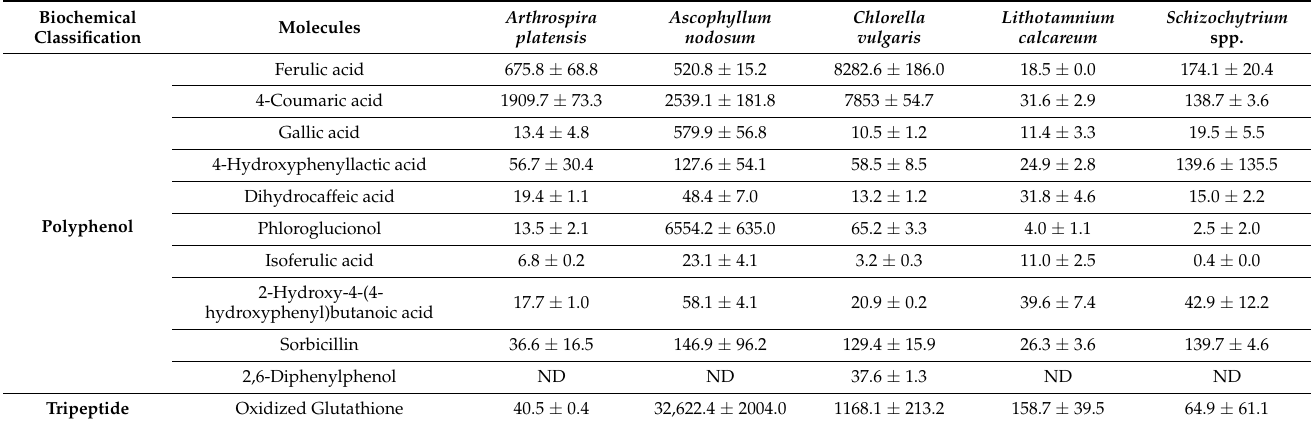
Table 3. Metabolomic profile related to the content of polyphenols and tripeptides of Arthrospira platensis ; Ascophyllum nodosum ; Chlorella vulgaris ; Lithothamnium calcareum and Schizochytrium